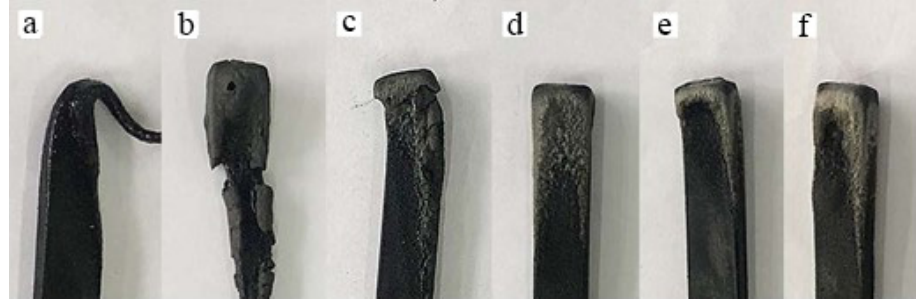
Figure 6. Images of BC/PLA composites after UL94 test: ( a ) BC/PLA (25/75), ( b ) AHP/BC/PLA (25/70/05), ( c ) AHP/BC/PLA (25/65/10), ( d ) AHP/BC/PLA (25/60/15), ( e ) AHP/BC/PLA (25/55/20) and ( f ) AHP/BC/PLA (25/50/25). Table 5. Synergistic e ff ect of BC and AHP on